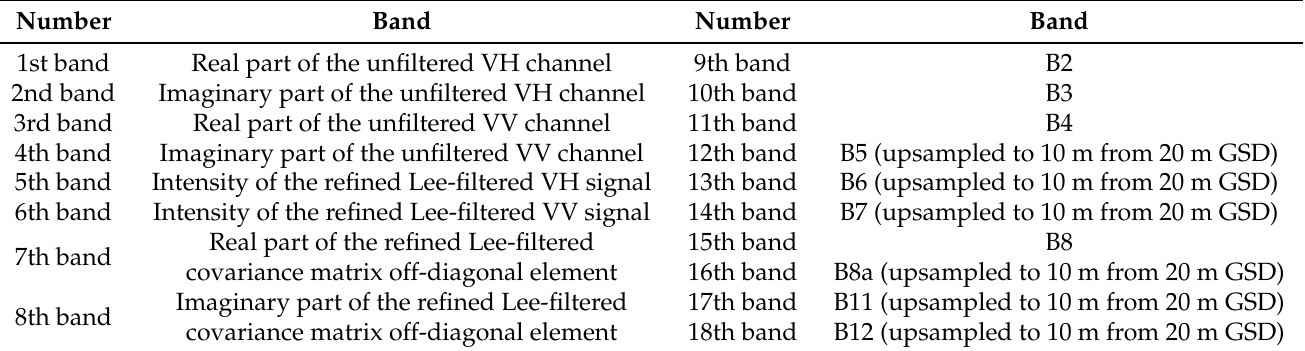
Table 1. Selected features from Sentinel-1 (band 1–8) and Sentinel-2 (band 9–18) data.